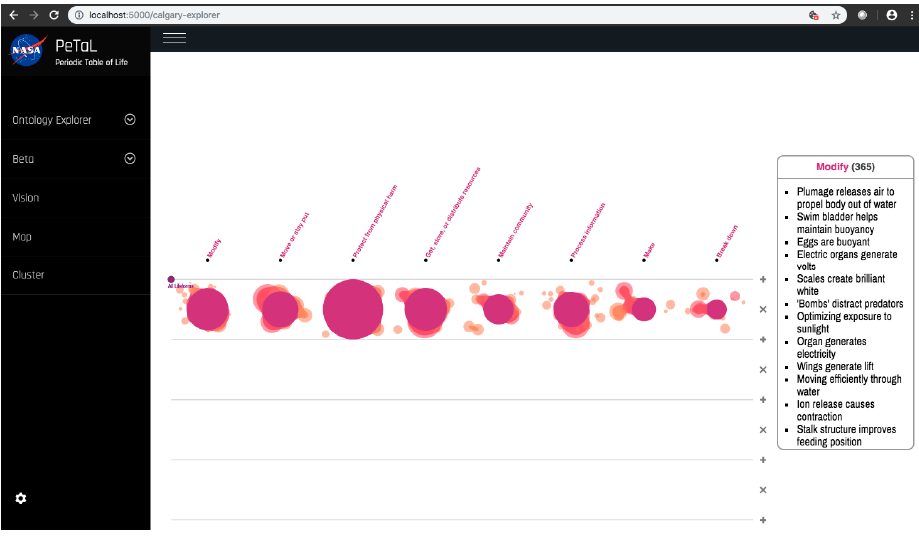
Figure 30. AskNature explorer tool [64] in the PeTaL UI.